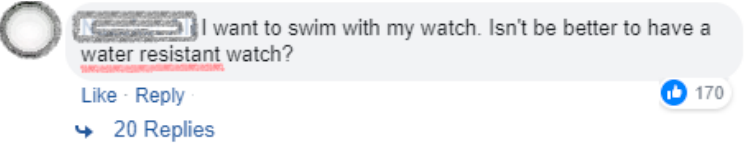
Figure 4. User comment demanding water-resistant smartwatch.